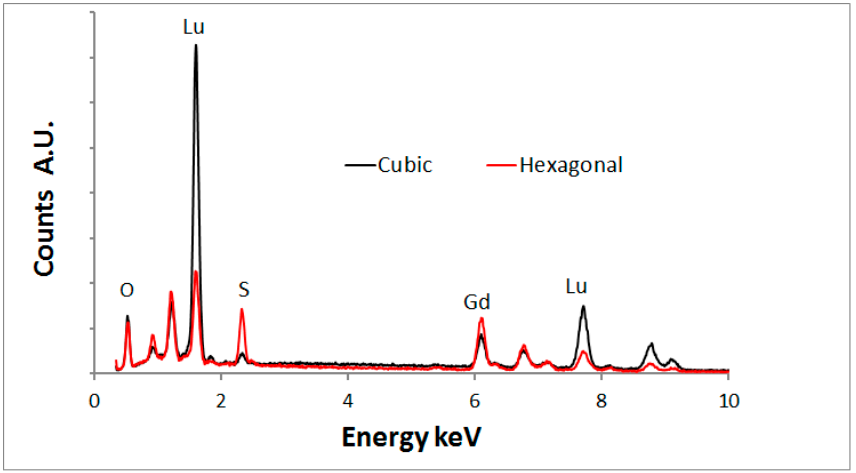
Figure 10. Overlay of EDS ‐ spectra of the cubic and hexagonal type crystals in (Lu 0.5 Gd 0.5 ) 2 O 2 S:2%Tb 3+ .